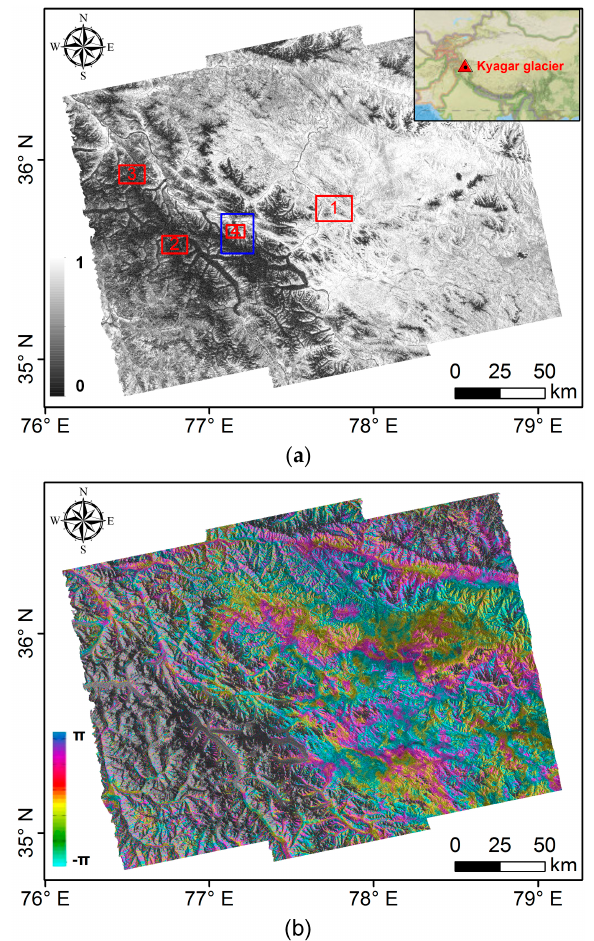
Figure 3. ( a ) Differential synthetic aperture radar (SAR) interferometry (DInSAR) coherence image, derived from Sentinel-1A SAR data acquired on 6 August 2018 and 18 August 2018. The numbered areas marked in the coherence image are test samples shown in Figure 4; the blue rectangle indicates the location of Kyagar Glacier. ( b ) Interferometric phase map of the test area. The background is from the intensity image. The color scale gives the DInSAR phase.